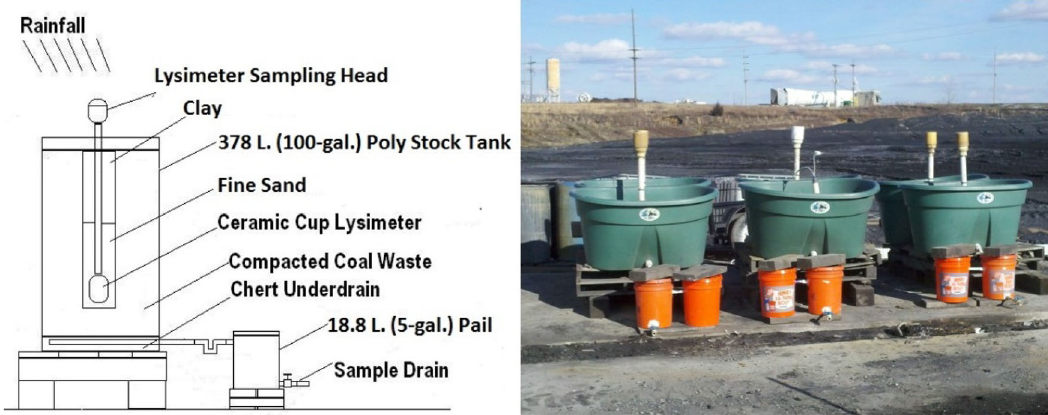
Table 6 Average concentration of selected mine drainage parameters in leachate.* refuse type Interval (months) pH CCPW-Only CCPW/FCPW blend CCPW/FCPW/limestone